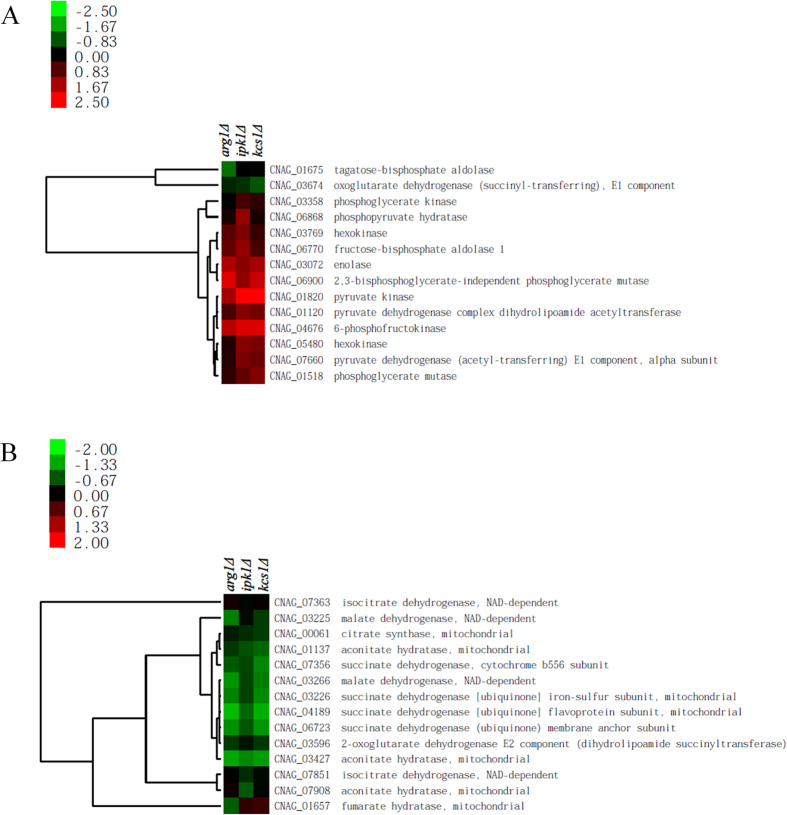
Expression of glycolysis (A) and TCA cycle (B) associated genes in arg1Δ, ipk1Δ and kcs1Δ mutants, relative to WT H99.Wild type and mutant cultures grown overnight in YPD broth were used for RNA extraction, followed by RNA-seq gene expression analysis (green, down-regulated expression; red, up-regulated expression). The colour bar to the left of each heat map demonstrates the log2 fold changes from comparison of each mutant to WT.